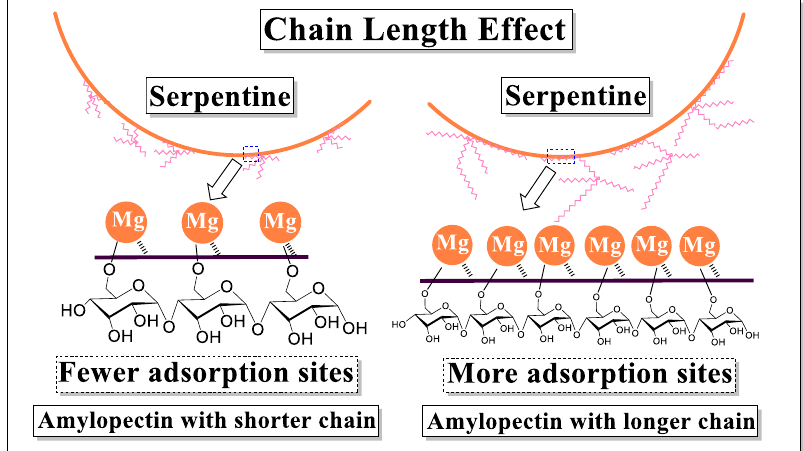
Figure 10. The schematic diagram for the interactions between depressants and serpentine.